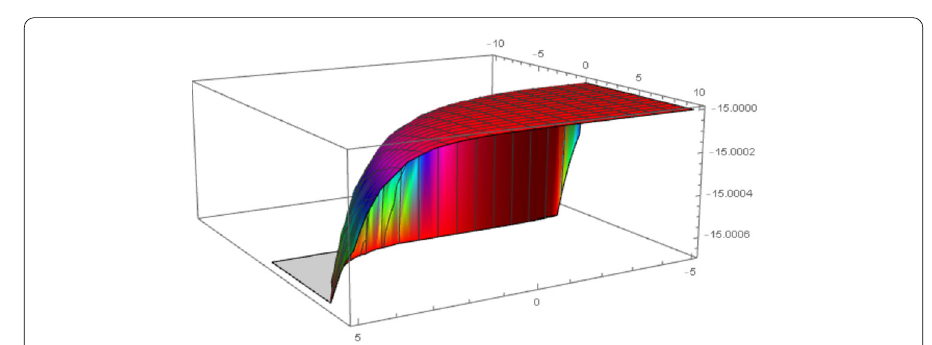
Figure 11 Solitonic solution of u 14 ( η ) for α = 0.9, a 0 = 0.5, λ = –1, b 0 = 11, V = 0.1, k = 3